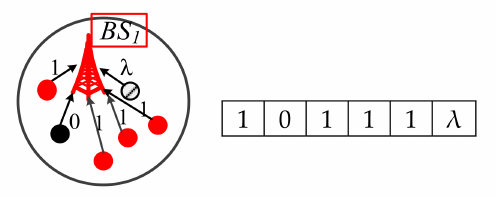
Figure 7. An example of the communication range of a specific BS 1 .